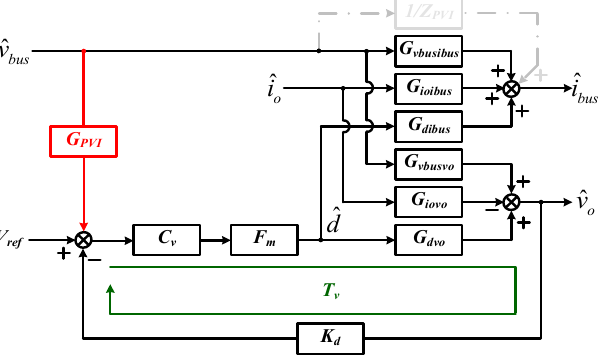
Figure 15. Control block diagram of the realization of parallel virtual impedance.